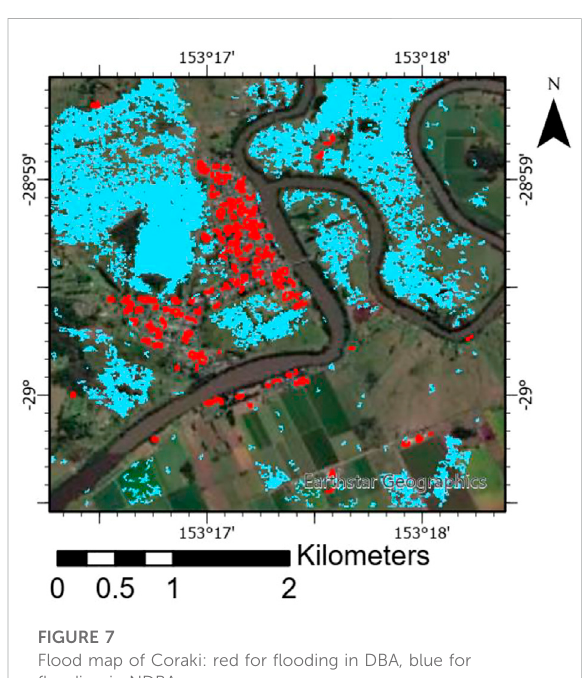
FIGURE 7 Flood map of Coraki: red for fl ooding in DBA, blue for fl ooding in NDBA.